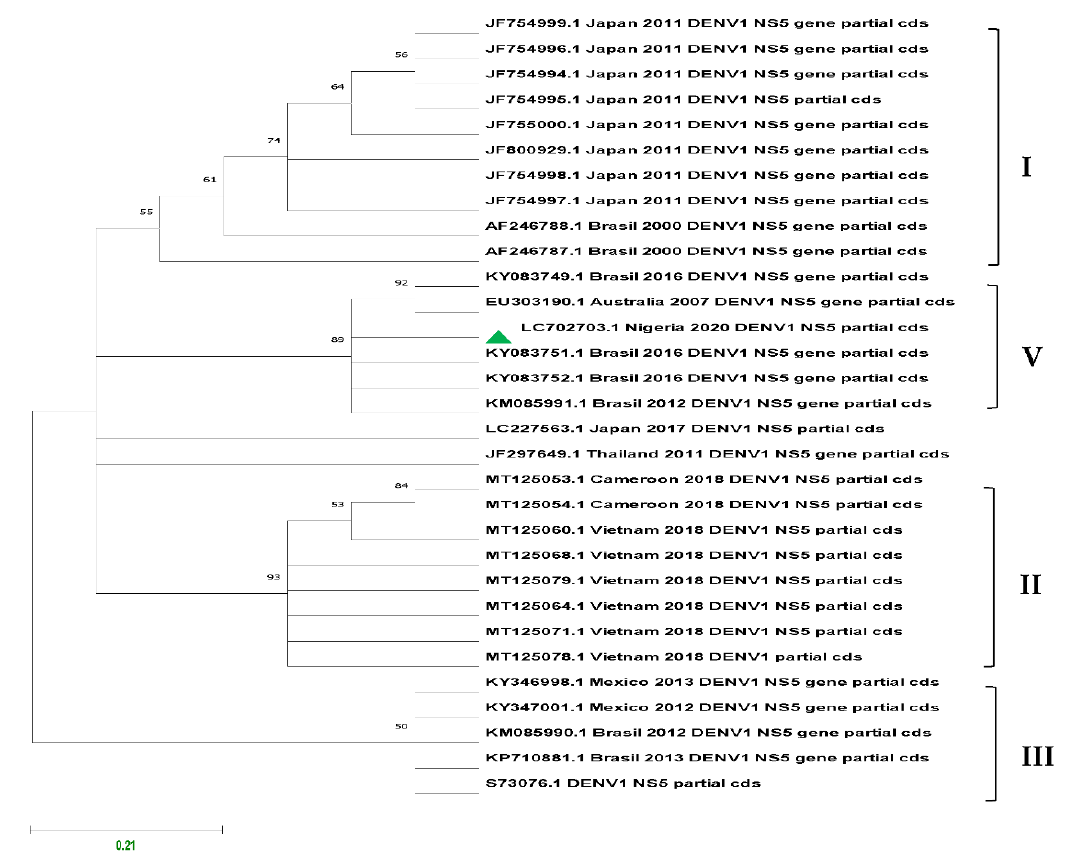
Figure 8. Maximum Likelihood phylogenetic tree of DENV1 based on partial NS5 gene of 109 nt length and 31 sequences deposited in GenBank generated using GTR + G nucleotide substitution model. Bootstrap values are shown on branch nodes and annotation on the right denote genotypes (Asian I, Asian/American II, Cosmopolitan III, African/American V). Sequence from this study is indicated with green marker with accession number